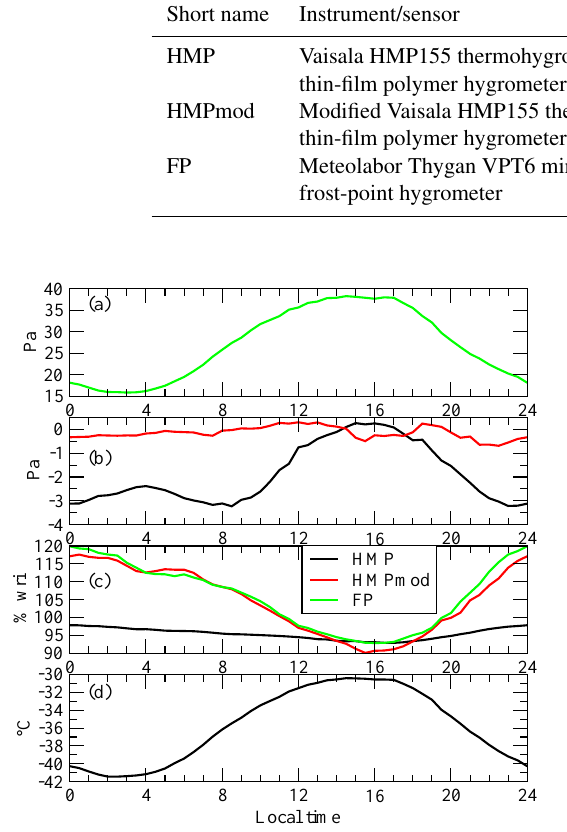
Figure 4. Mean December–January–February diurnal cycle of: (a) water vapor partial pressure from FP instrument; (b) difference with respect to FP of water vapor partial pressure from original (HMP, black) and modified (HMPmod, red) thin-film polymer sen- sors; (c) RH i from the three instruments; (d) 3m air temperature.